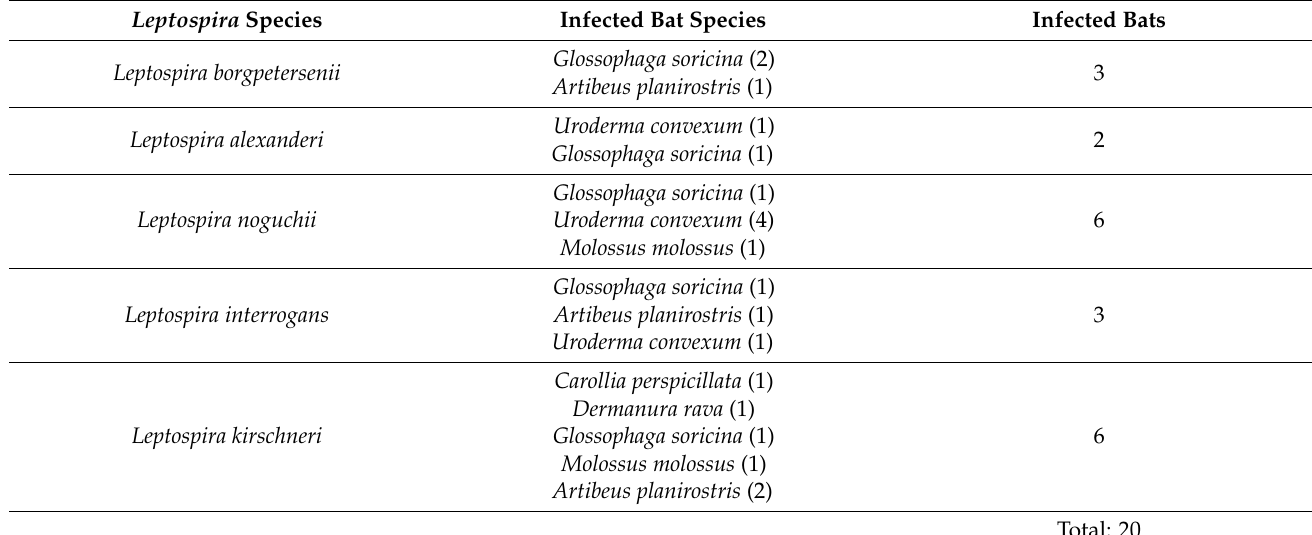
Figure 4. Identification of Leptospira species infecting bats by phylogenetic analysis of the 16S ribosomal gene. Phylogenetic reconstruction of the 16S ribosomal gene of the genus Leptospira is shown. Red diamonds represent the bats infected with Leptospira spp. in this study. Leptospira borgpetersenii , Leptospira alexanderi , Leptospira noguchii , Leptospira interrogans , and Leptospira kirschneri were the Leptospira species found infecting this bat population. Table 3. Natural infection of bats with different Leptospira species. The table shows the host-pathogen relationship between 6 Leptospira species and 6 bats species susceptible to infection. The number of bats infected by each Leptospira species is shown in